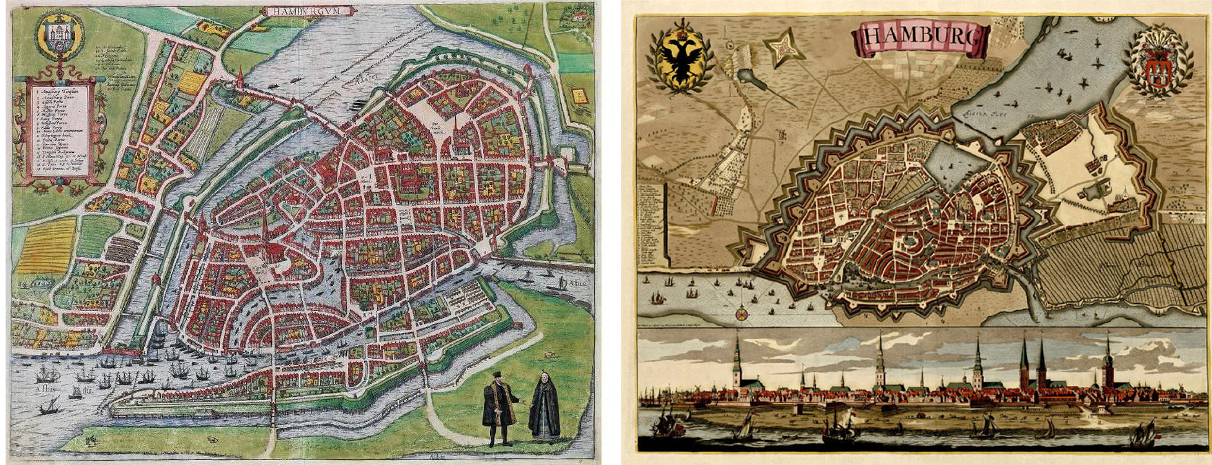
Figure 1. Hamburg in 1589 and 1690. (a) Hamburg in 1589, kol. Kupferstich von G. Hufnagel (left); (b) Hamburg in 1690, kol. Kupferstich von P. Schenk (right). Source: Hoffmann and Frank (2009).